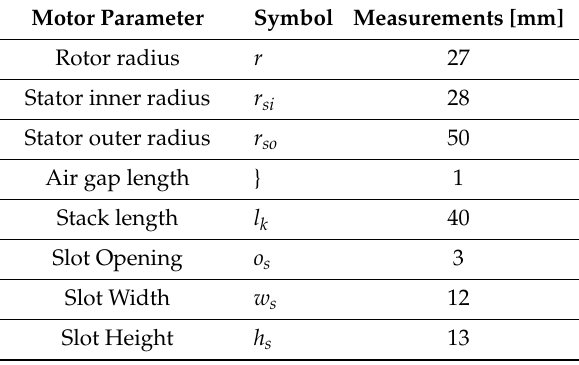
Table 2. Dimensions of the motor used for experiments.